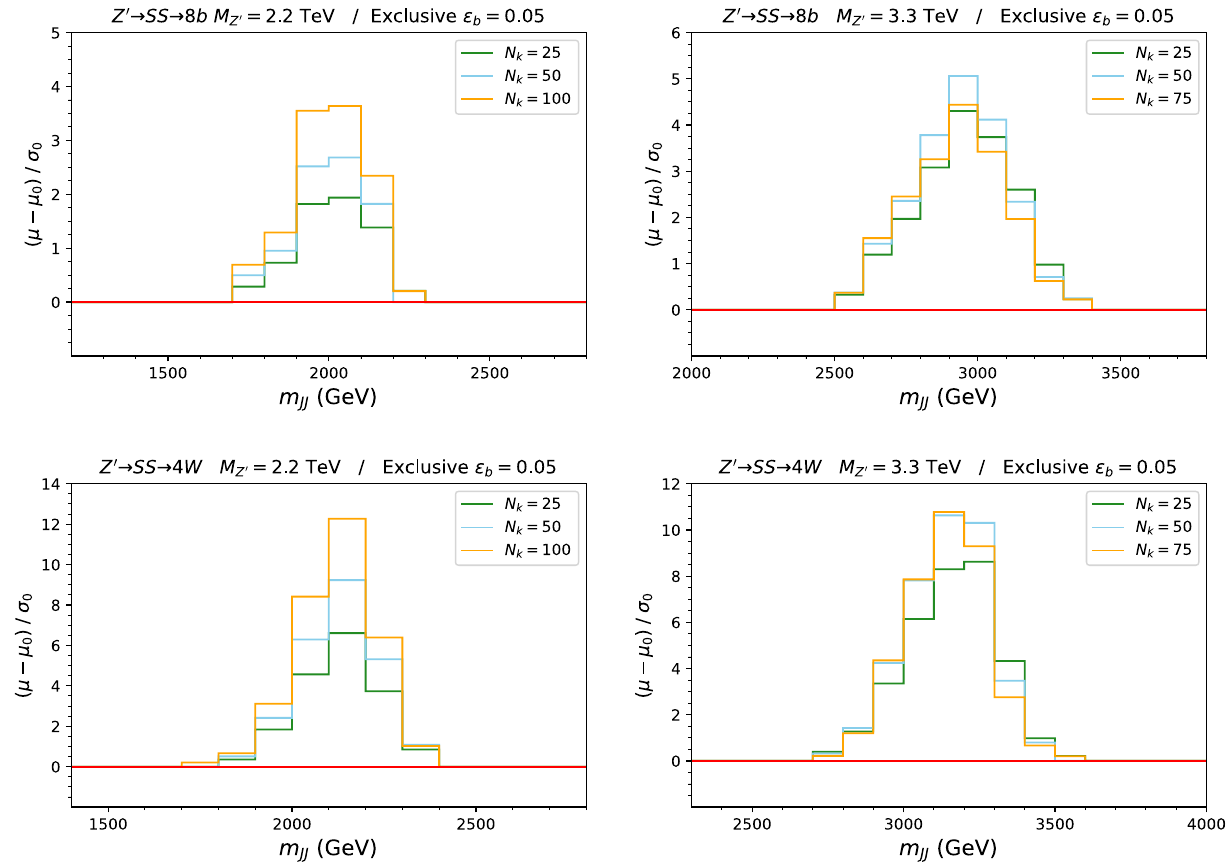
Fig. 18 Expected sensitivity (per 100 GeV bin) to Z (cid:6) signals using the T estimator alone in the four benchmarks described in Sect. 5, for several values of N k even be adjusted bin-by-bin, performing the search for a few N k